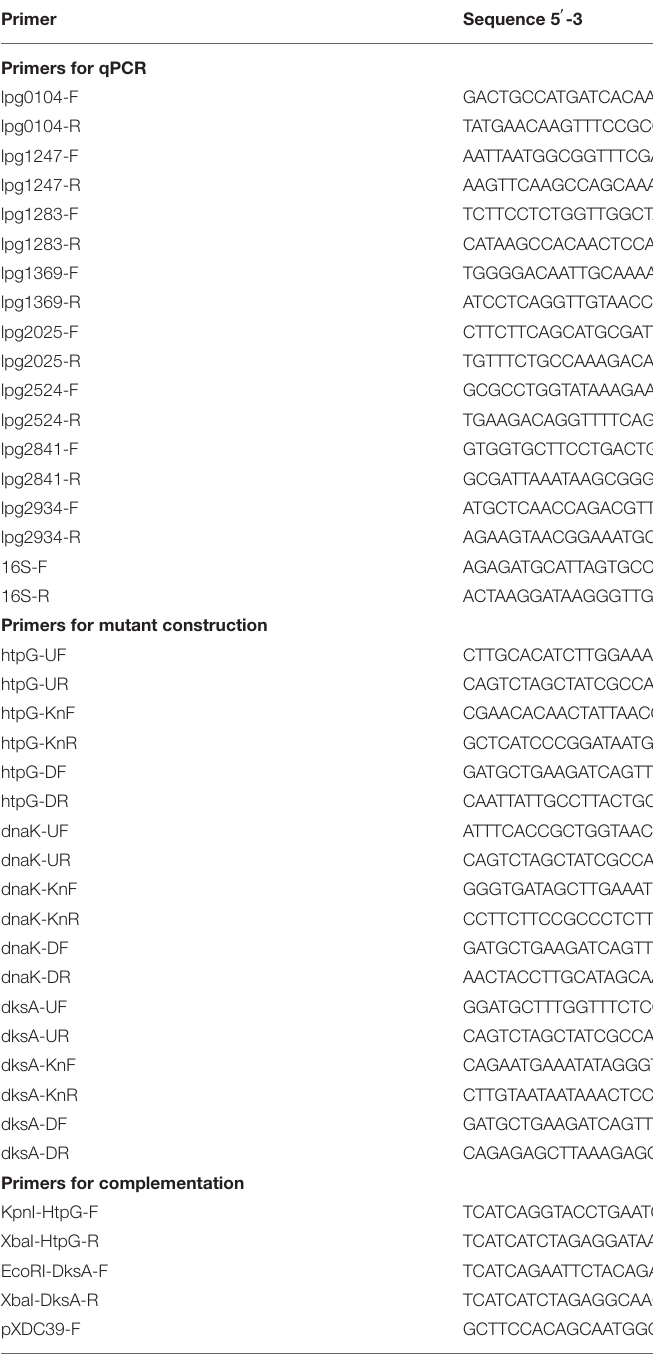
TABLE 2 | Primers used in this study.